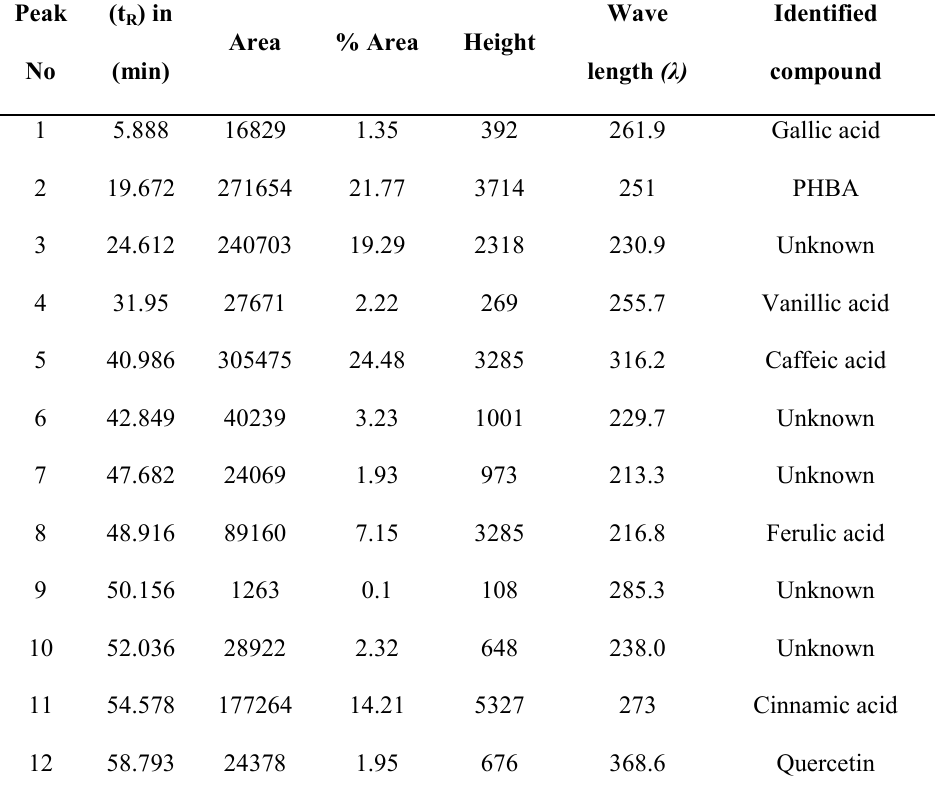
Table 3. HPLC Chromatographic data of Eleusine coracana (L.)